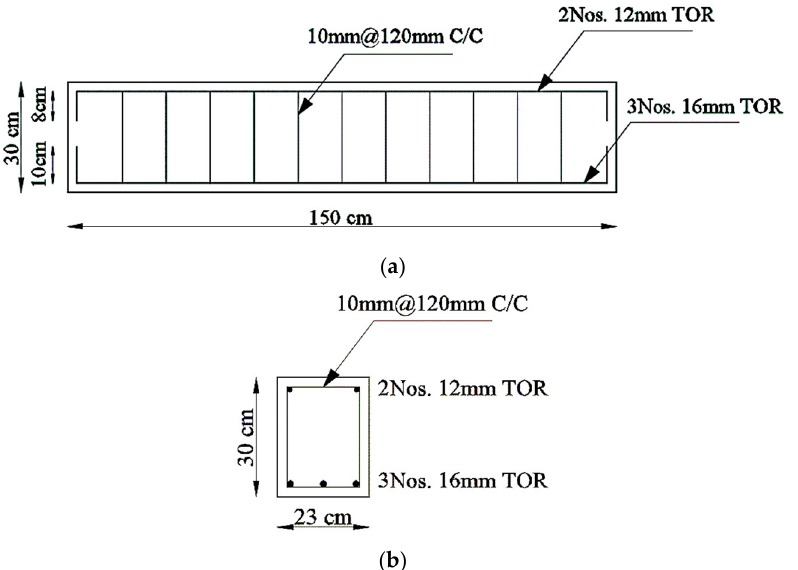
Figure 2. Concrete Dimensions and Reinforcement Details for the Verification Models. ( a ) Elevation. ( b ) Cross-Section.